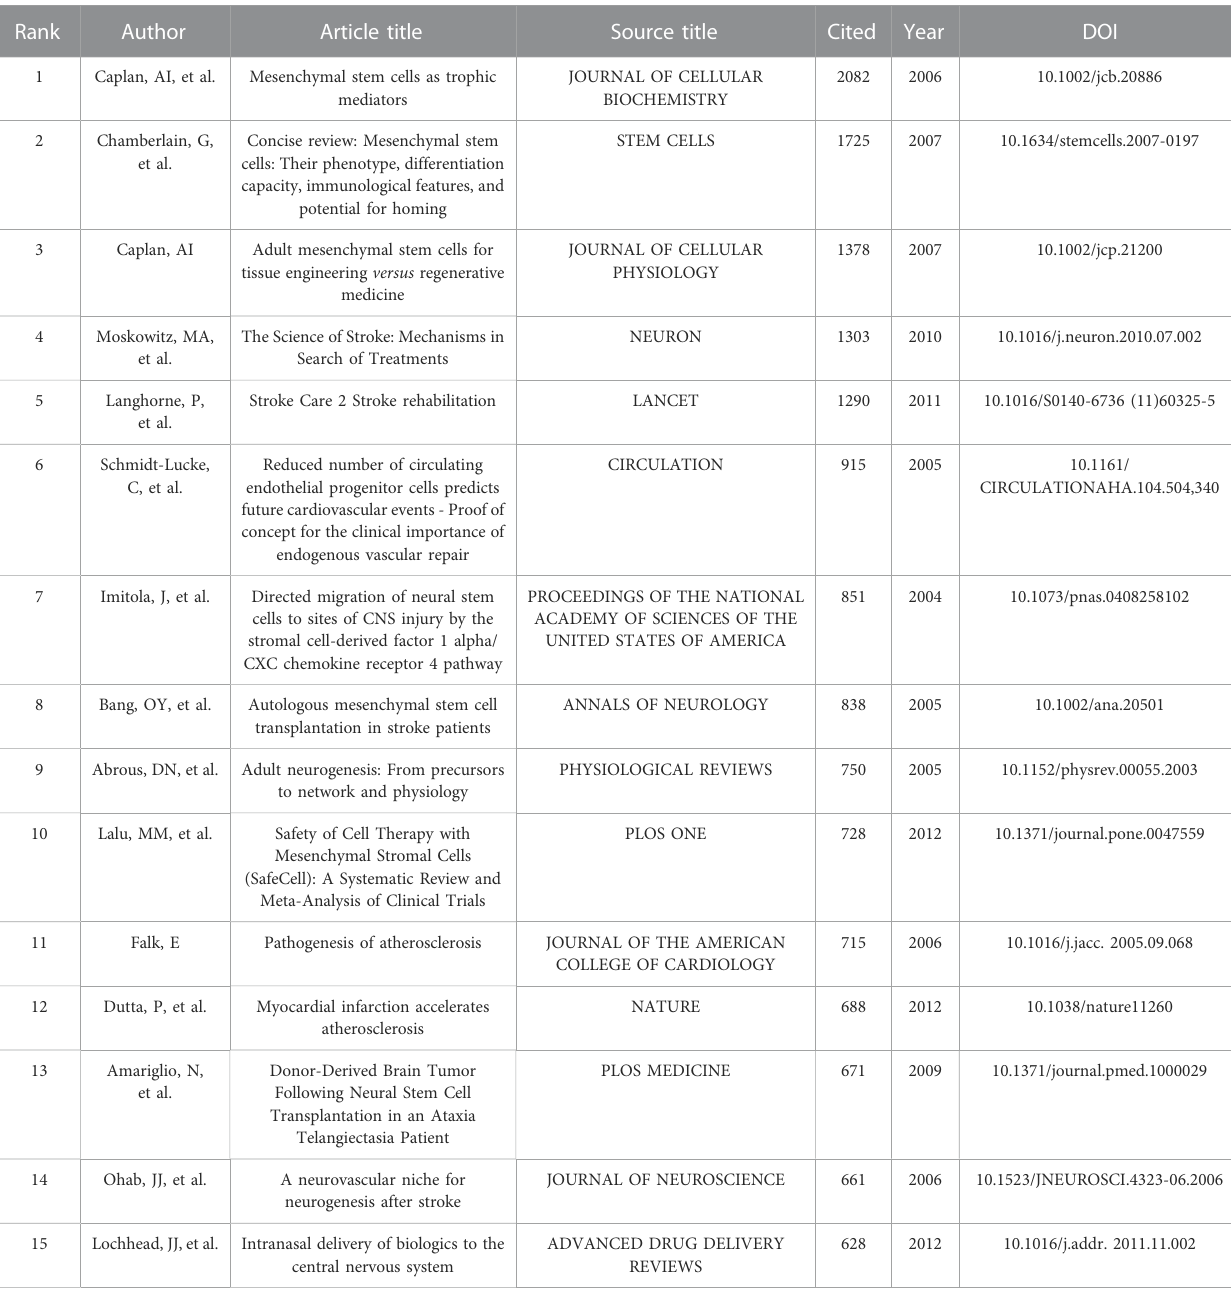
TABLE 5 Top 15 co-cited references related to stem cells in